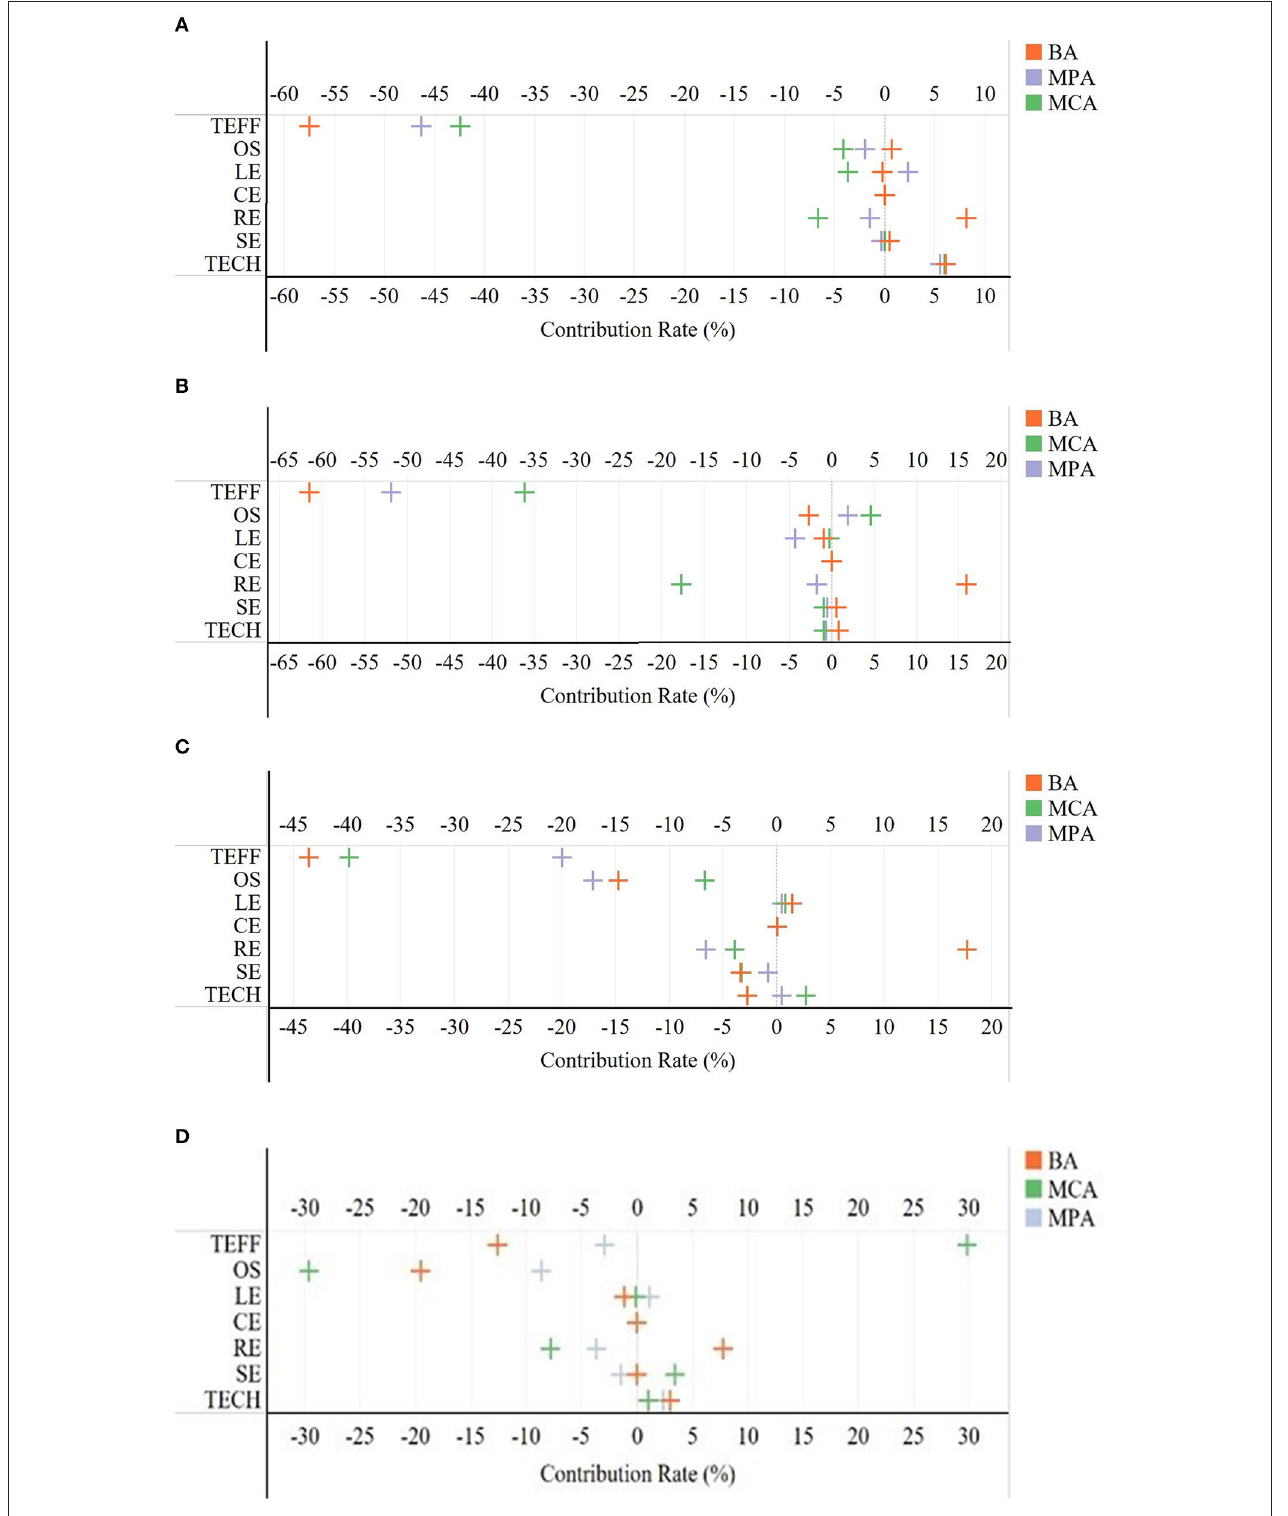
FIGURE 5 | Decomposition results in three regions at different periods. (A) 2001–2006, (B) 2006–2011, (C) 2011–2016, and (D) 2016–2018.